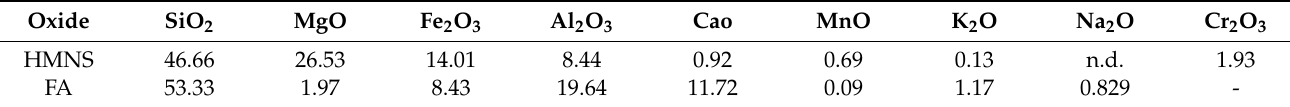
Table 1. Chemical composition of HMNS and